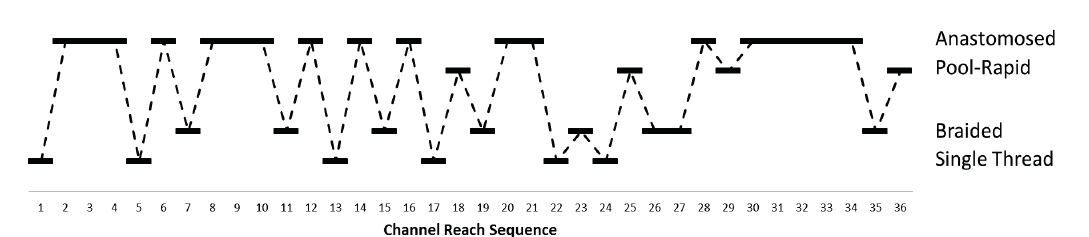
Fig. 2 Channel type variation exhibited over a 106 km length of the Sabie River prior to the extreme flood of January 2000 (1 = most upstream reach type, 36 = most downstream reach type). The ‘anastomosed’ category includes both bedrock anastomosed and mixed anastomosed